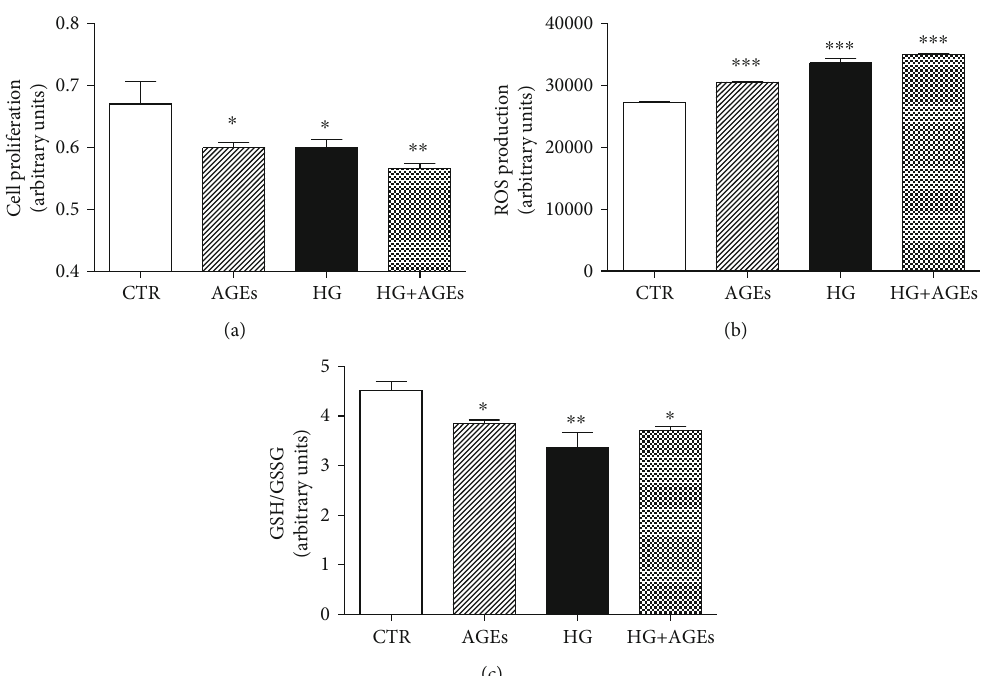
Figure 1: Cell viability and oxidative stress in HMEC-1 cells cultured for 5 days in standard medium (CTR), in the presence of glycated serum (AGEs), 25 mM glucose (HG), and with their combination (AGEs+HG). (a) Cell proliferation rate ( n = 4 , ∗ p < 0 : 05 and ∗∗ p < 0 : 01 vs. CTR). (b) Evaluation of intracellular ROS production ( n = 4 , ∗∗∗ p < 0 : 001 vs. CTR) (c) Ratio between the reduced (GSH) and the oxidized (GSSG) forms of glutathione ( n = 4 , ∗ p < 0 : 05 and ∗∗ p < 0 : 01 vs. CTR). Values shown indicate the mean SEM of at least 3 independent